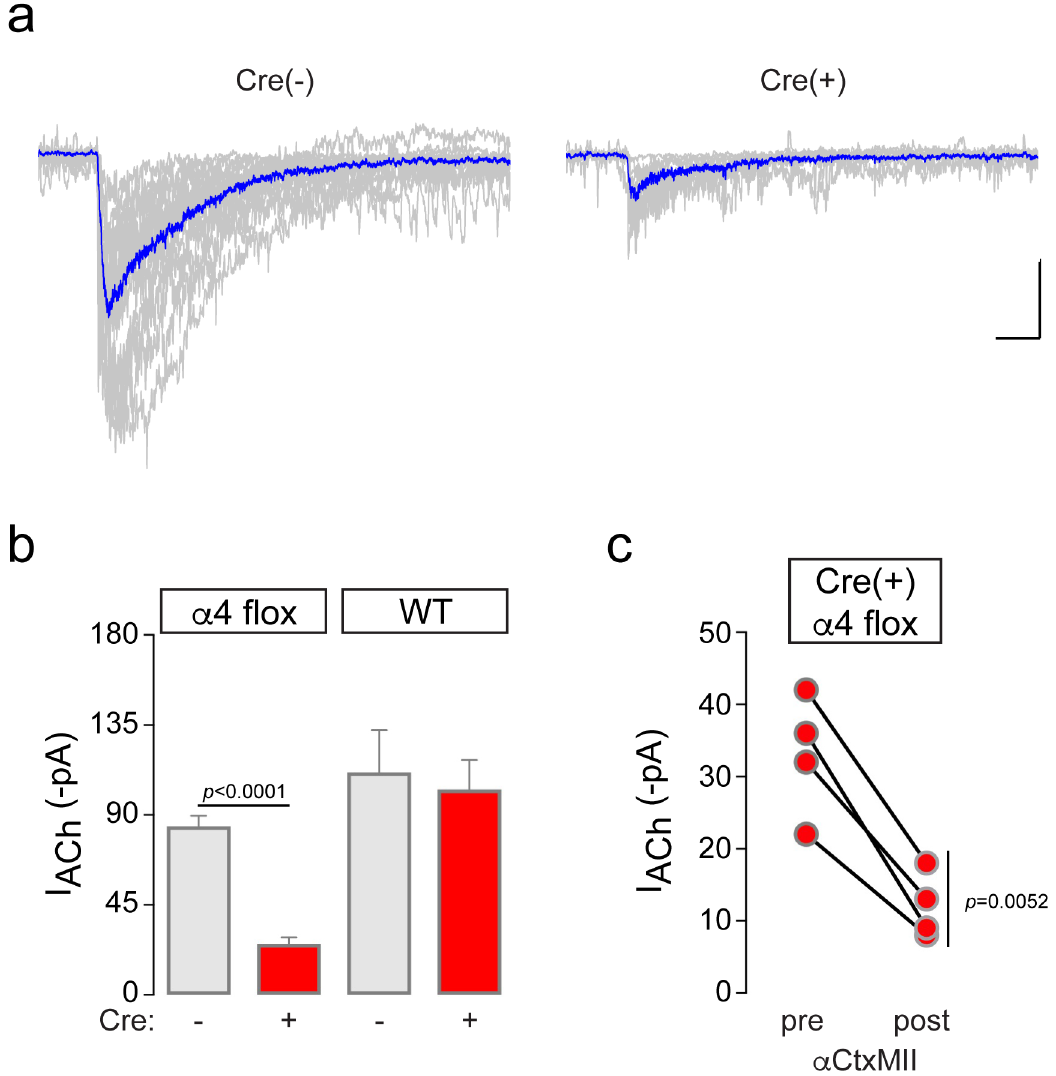
Fig 4. Functional deletion of α 4 subunits in VTA. a) Recordings were made from α 4-flox;Cre(-) and Cre(+) VTA DA neurons. ACh (1 mM) was appliedby pressureejectionand inward currents were recorded. All recordedtraces are shown in gray, and an averagedtrace is shown in blue. Scale bar: 40 pA, 400 ms. b) Quantification of ACh-evoked currents in AAV-infected mice. Mean inwardACh-evokedcurrents from α 4-flox;Cre(-) (n = 19 cells from n = 9 animals), α 4-flox;Cre(+) (n = 14 cells from n = 5 animals), WT;Cre(-) (n = 7 cells from n = 2 animals),and WT;Cre(+) (n = 8 cells from n = 2 animals) cells ± SEM. **** p < 0.0001 (unpaired t -test, t = 8.788). c) ResidualACh-evokedcurrents in α 4-flox;Cre(+) neuronsare α CtxMII-sensitive. For Cre(+) responses in (B), α CtxMII (100 nM) was appliedby superfusion and ACh was re-applied after 12–15 min. Before-after responses for n = 4 α CtxMII-treated neurons(n = 2 animals)are shown. ** p = 0.0052 (paired t -test, t =